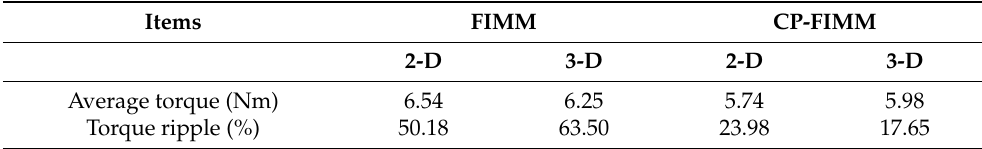
Figure 20. Torque waveforms of 2-D and 3-D FE analysis. Table 4. Torque comparison between 2-D and 3-D analysis.